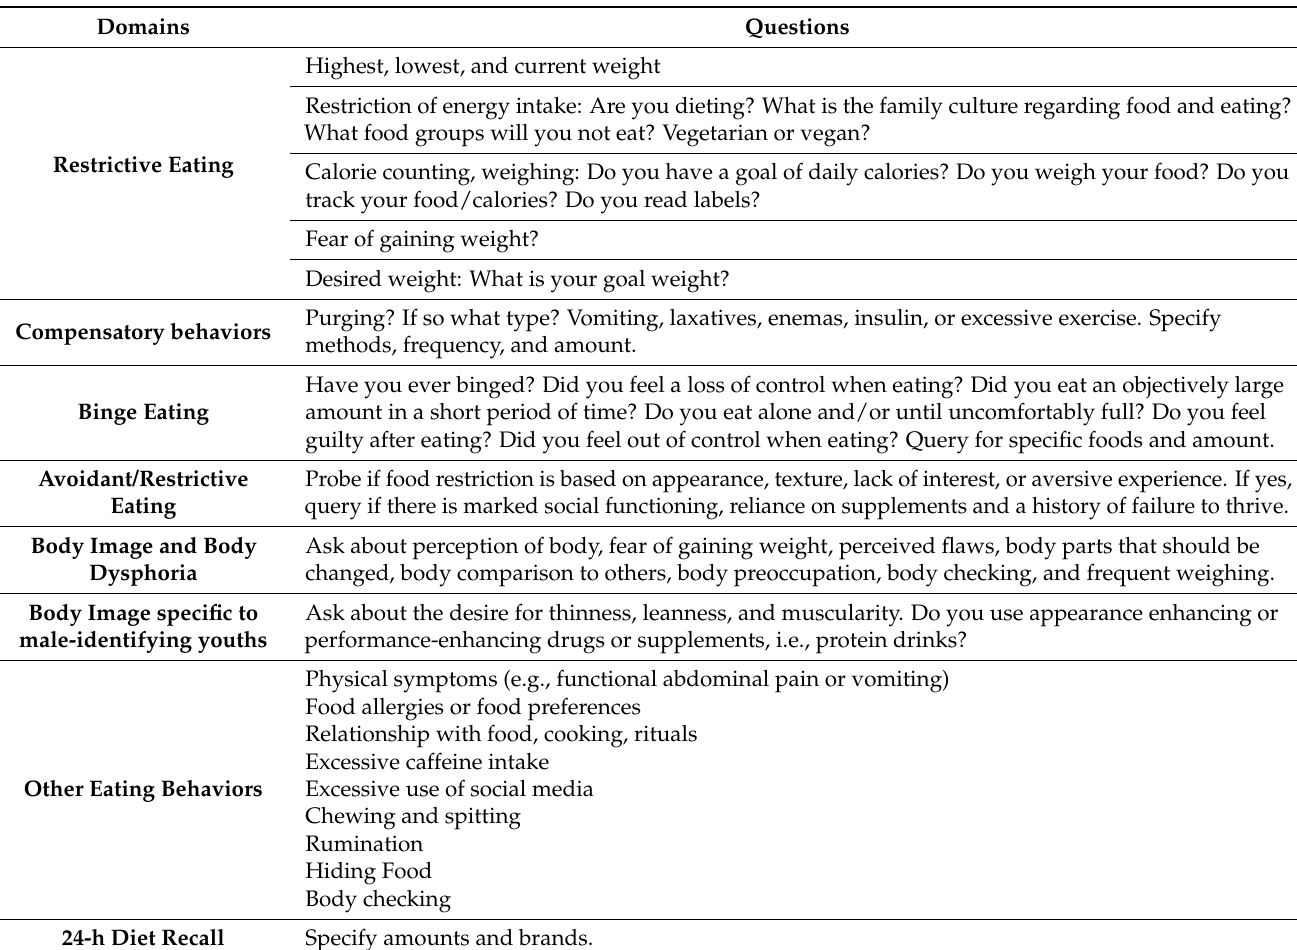
Table 2. Eating Disorder